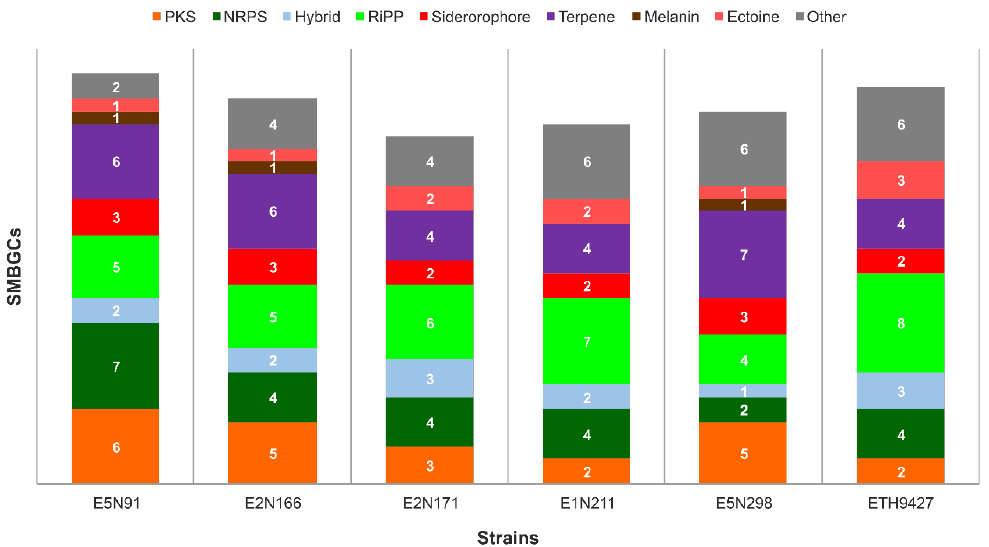
Figure 2. Specialized metabolite biosynthetic gene clusters identified in analyzed strains. Genome sequences were analyzed with antiSMASH 3.0 for gene cluster identification. The “Hybrid” category refers only to PKS-NRPS hybrid gene clusters. Other hybrid clusters that were detected were separated into their constituent parts to better visualize cluster diversity. Clusters encoding bacteriocins, lantipeptides, and lassopeptides are grouped in the category “RiPP”, and the category “Other” includes other KS pathways and less common clusters such as phenazines and butyrolactones, among